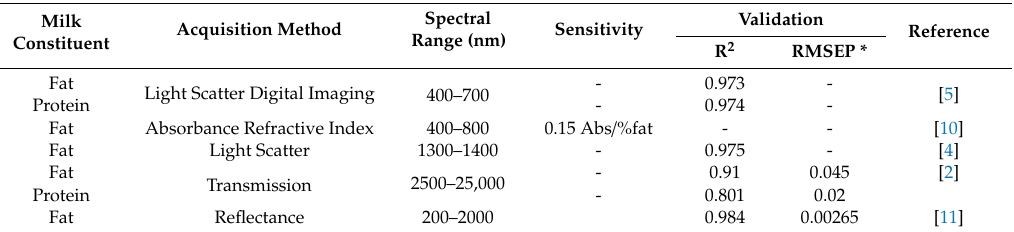
Table 3. Comparison of similar research in